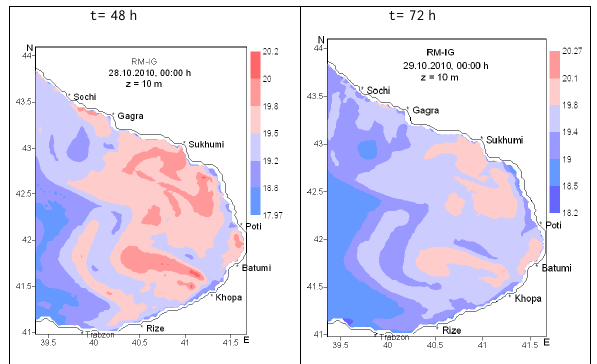
Fig. 18. The temperature fields (deg. C) on depth of 10 m predicted by BSM of MHI at 48 h (a) and 72 h (b) (forecasting period is 26.10.2010, 00:00 h – 29.10.2010, 00:00 h).